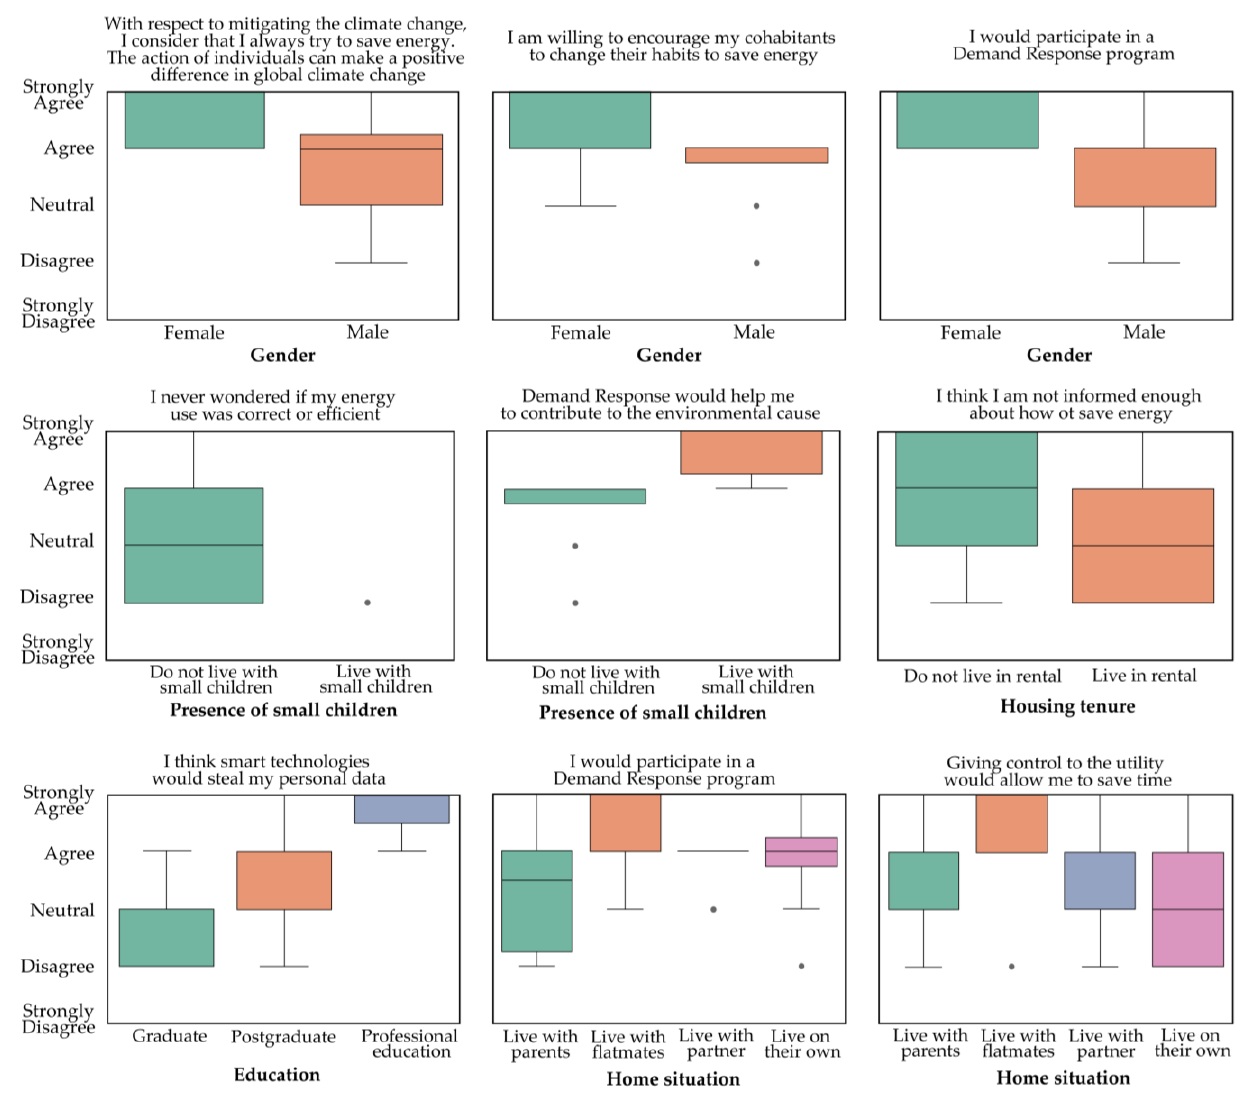
Figure 2. Boxplots of the significant differences in terms of the demographics on the level of knowledge. The y -axis represents the 5-point Likert scale, while on the x -axis, the categories of the independent variables are shown.